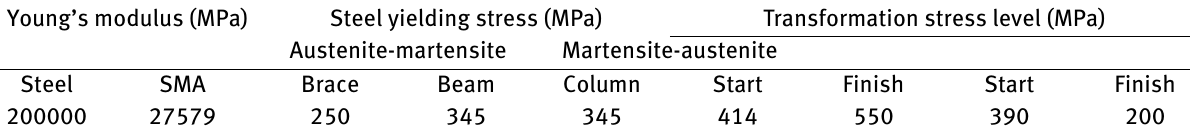
Table 1: Material Properties Adopted for the Numerical Simulations [35]. Young’s modulus (MPa) Steel yielding stress (MPa) Transformation stress level (MPa)